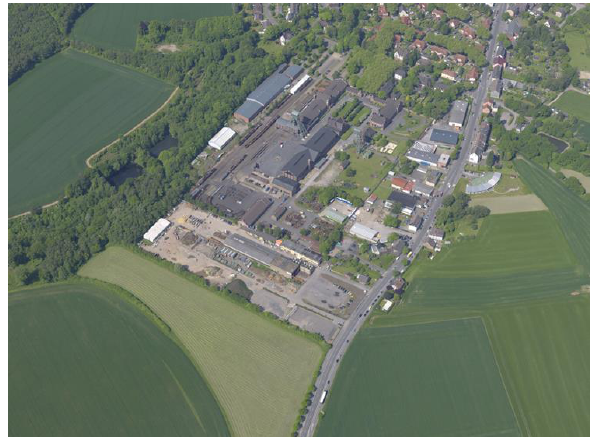
Figure 3. Exemplary image for test area Museum Zeche Zollern